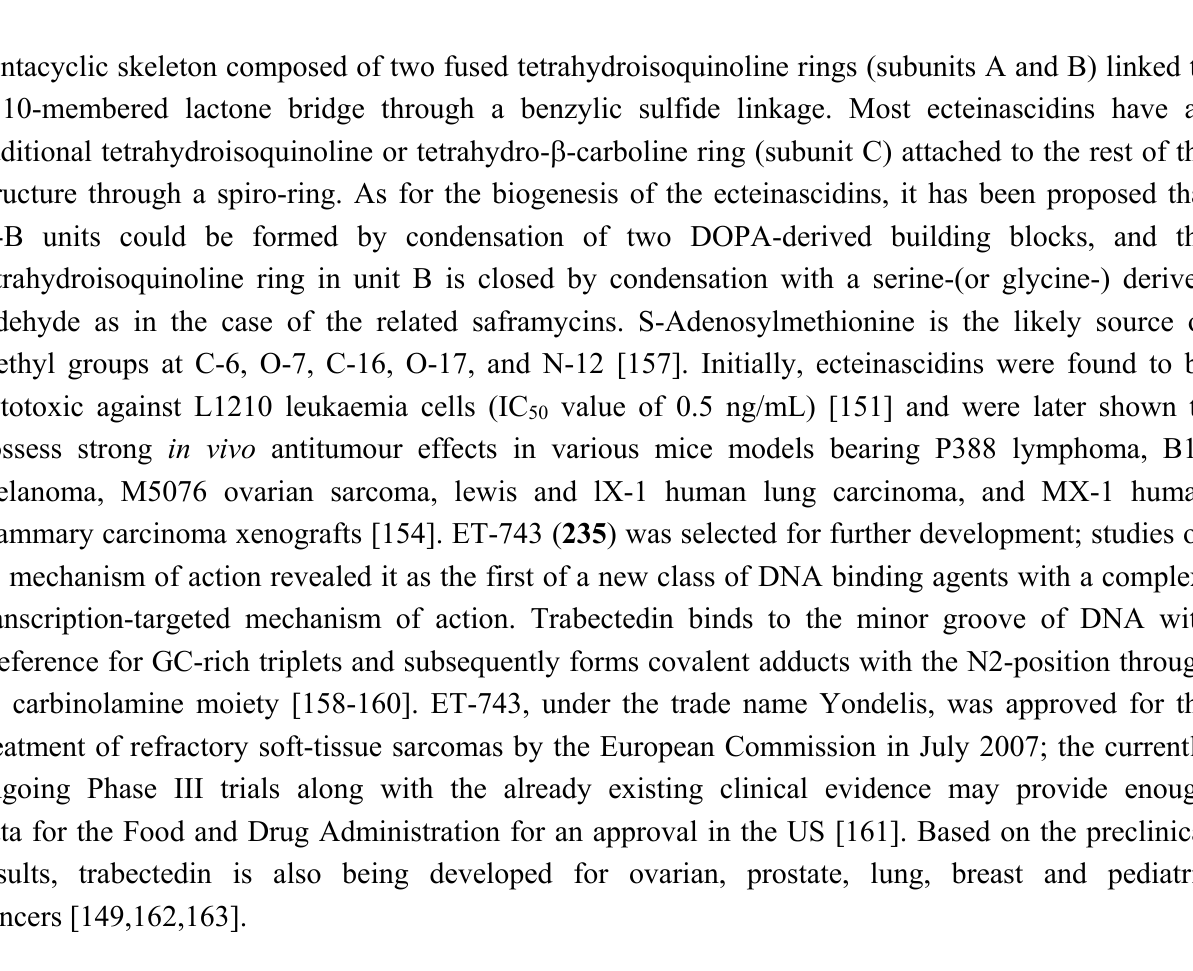
Figure 25. Structures of alkaloids related to